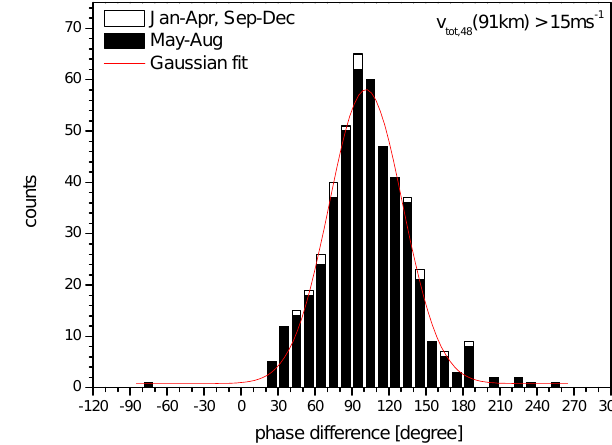
Figure 6. Histogram of the 91km (gate 4) phase differences of zonal and meridional components for amplitudes larger than 15ms − 1 . Black bars: summer (May–August) data, 460 days con- sidered. White bars: rest of the year (January–April, September– December) data, 17 days